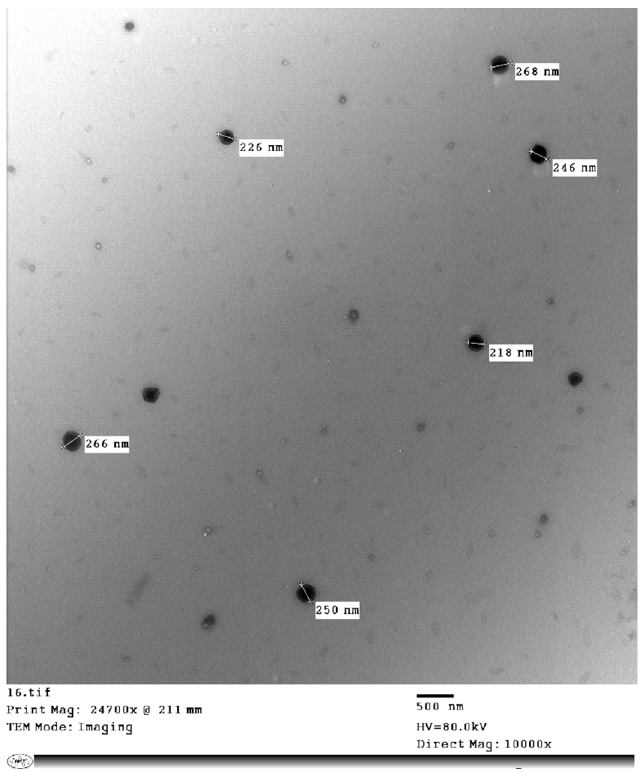
Figure 4. TEM images of synthesized ZnO-NPs.